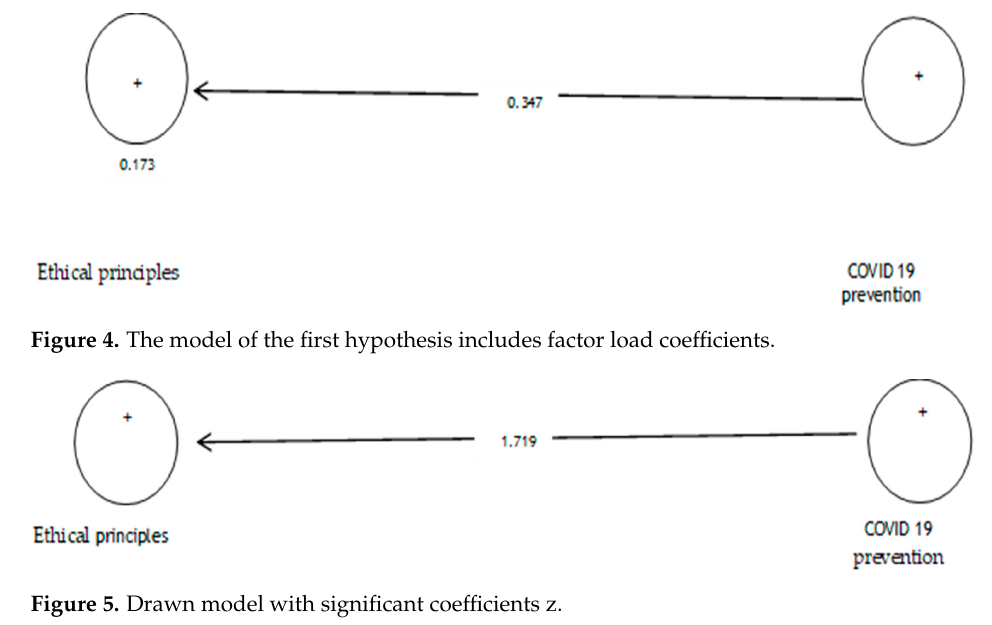
Figure 5. Drawn model with significant coefficients z. Table 5. Evaluation indicators of the internal model of the research The Relationship of Variables